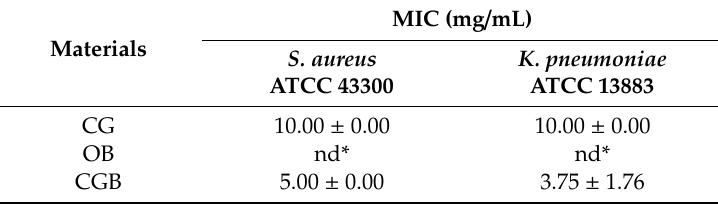
Table 3. Minimum Inhibitory Concentration (MIC) (mg / mL) for pure chitosan gels (CG) and associated with buriti oil (CGB) and buriti oil (OB) against S. aureus and K.